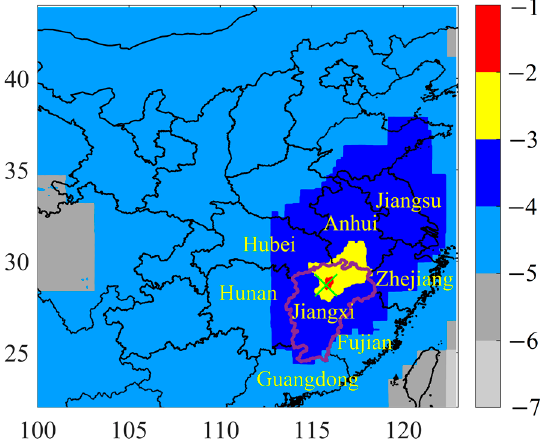
Figure 3. Averaged footprint from January to April, 2019, Jiangxi and the surrounding provinces are also labeled in yellow color, the observation site is represented using green “×”, the units for footprint: log10 (ppm · m 2 · s · mol − 1 ). Note the color bar represents different level of intensity of each footprint, with the red color being larger than the following colors. Table 1. Proportions of enhancement contribution from different provinces and Nanchang city, note Jiangxi province contains Nanchang city.